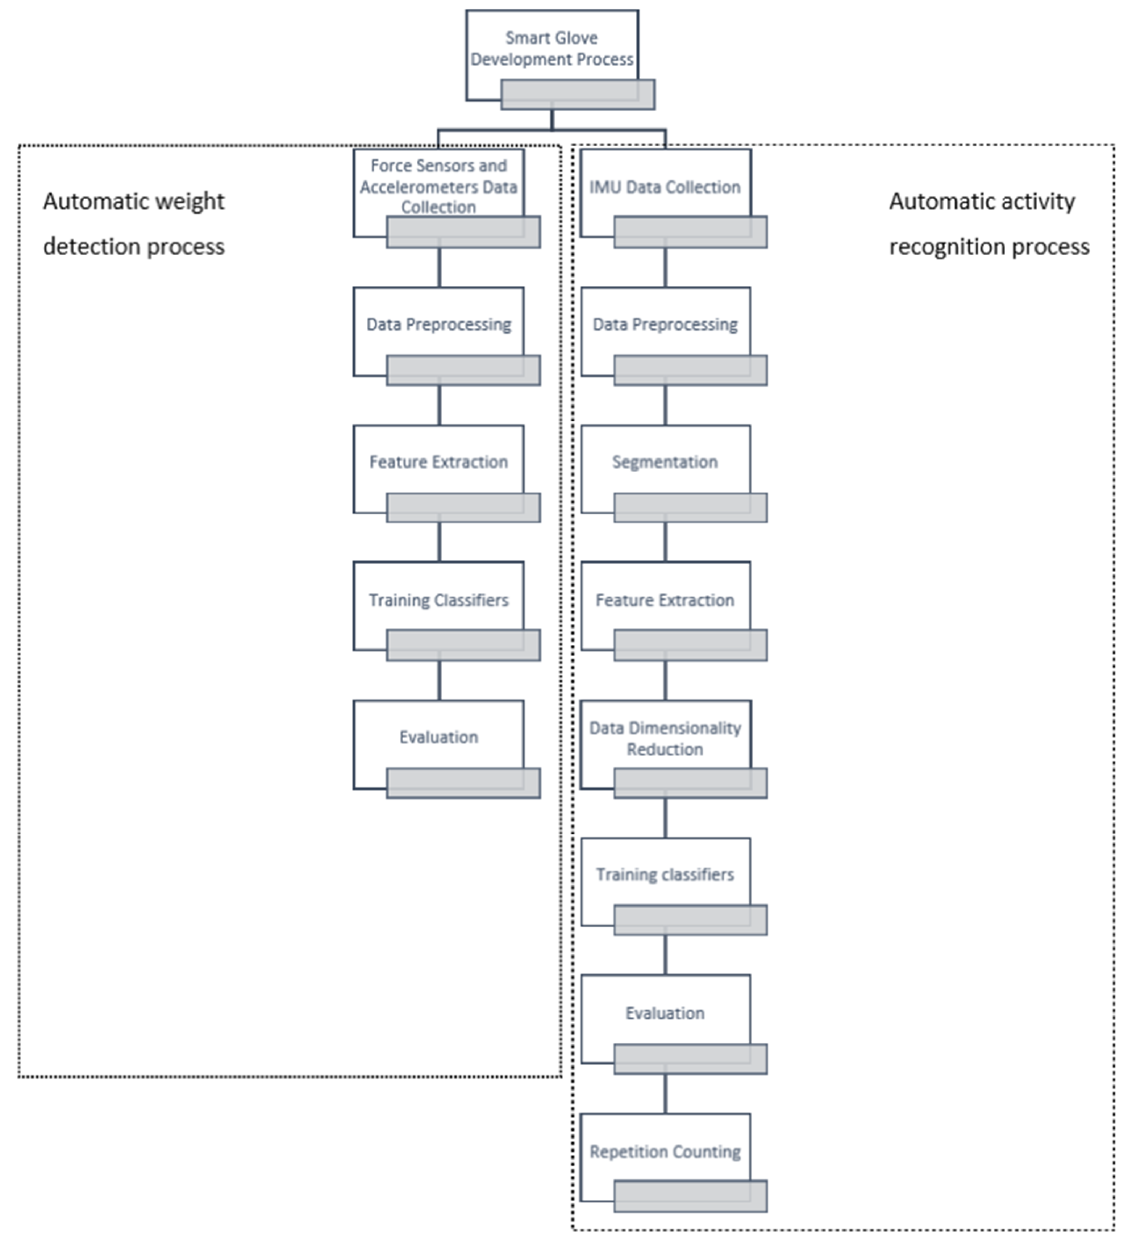
Figure 1. Block diagram of the proposed system.